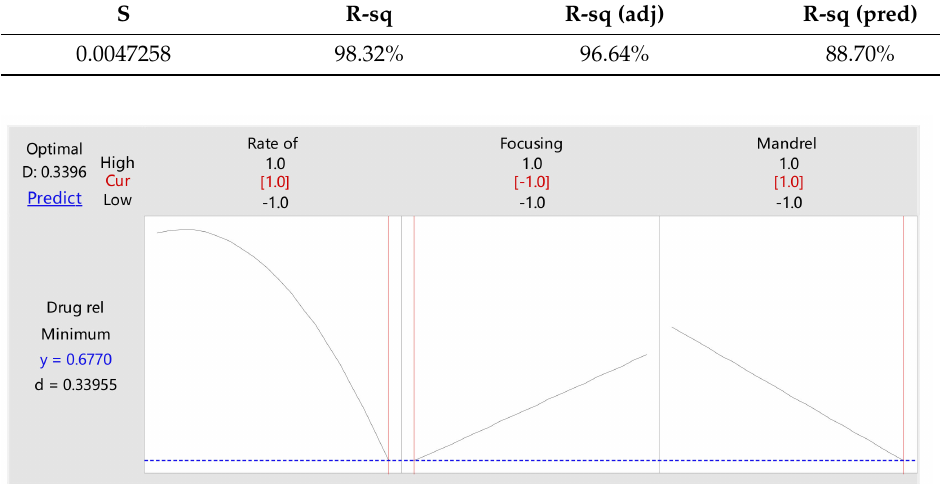
Table 2. Model Summary.